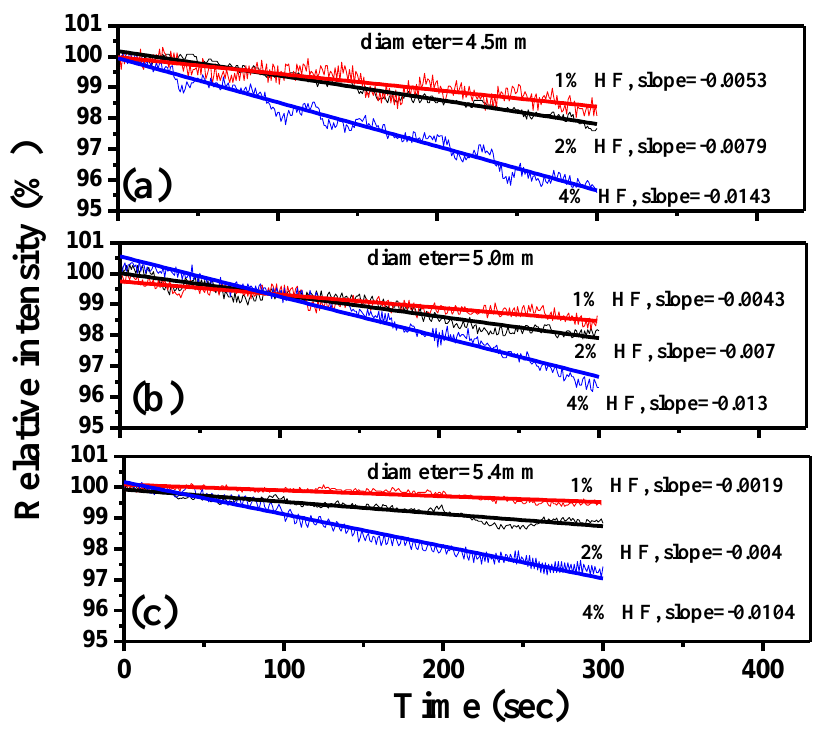
Figure 12. The curves of relative intensity versus time with various-diameter SiO (4.5 mm, 5.0 mm, and 5.4 mm) in SiO different concentrations (1.0%, 2.0%, and 4.0%). The formation of SiO R = 10, pH = 4, after standing for 3 days.